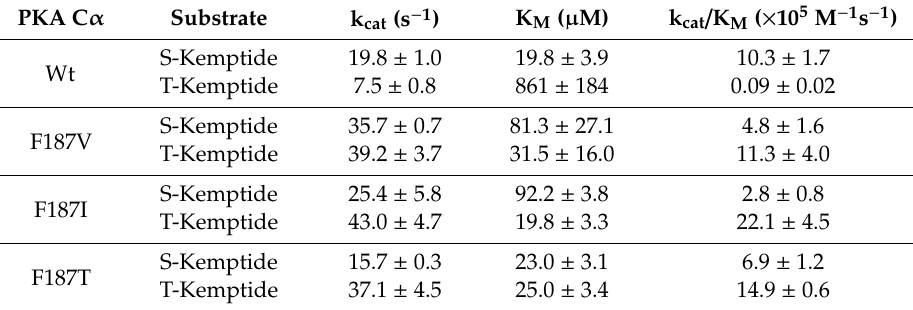
Table 1. The catalytic e ffi ciency of PKA C α mutants for serine and threonine substrates. k cat and K M values were determined using a spectrophotometric kinase assay (Figure S1). The values are represented as means of at least three independent measurements with standard deviation